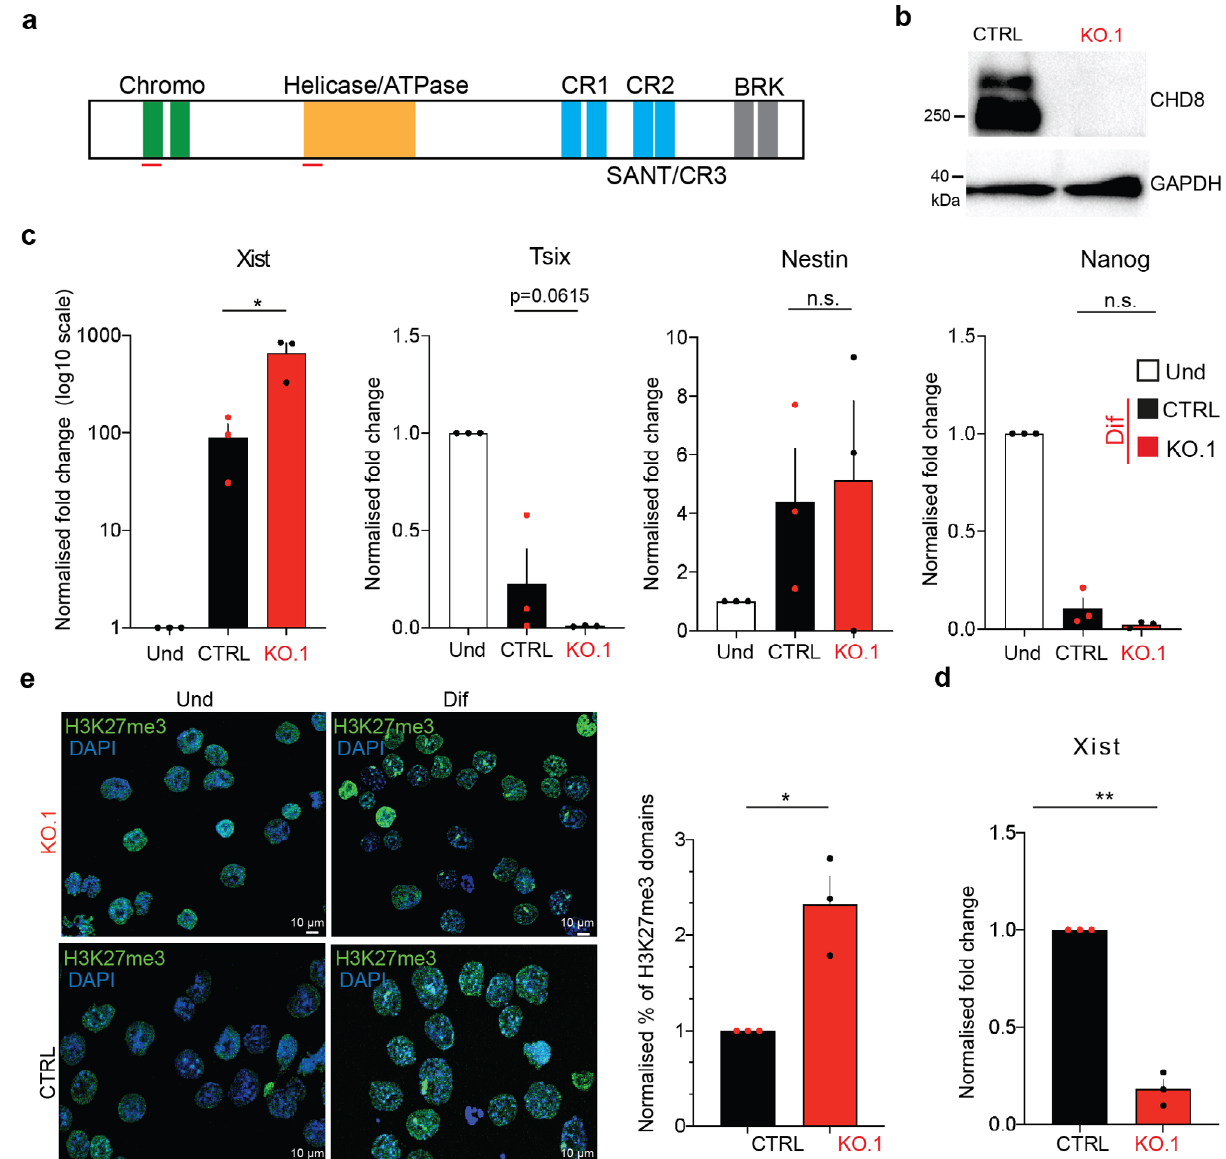
Fig. 3 Chd8 KO affects XCI initiation. a Schematic representation of Chd8 protein domains; red lines indicate the position of the CRISPR/Cas9 guides used (not in scale). b Western Blot analysis of Chd8 KO.1 (clone C4.1) and parental ES cells (CTRL, Fa2L-S4) are shown. c qRT-PCR results showing expression levels of Xist, Tsix , Nestin , Sox2 . In differentiating ESCs Xist is strongly up-regulated in Chd8 KO cells whilst cell differentiation is not affected ( Nestin , Nanog); CTRL, parental cell line: Fa2L-S4; KO, sub-clone C4.1. Data is normalised for the undifferentiated condition (Und). Data from three independent experiments is shown. p -values, Xist = 0.0367. d Xist qRT-PCR data from parental (CTRL) and KO.1 cells in undifferentiated state is shown. Und (undifferentiated cells), Dif (3 day differentiated cells). Data from three independent experiments is shown. Error bars represent standard error of the mean (SEM). Statistical signi fi cance was tested by means of two-tailed unpaired t -test (* p ≤ 0.05; ** p ≤ 0.01). p -values, Xist = 0.00362. Single points represent independent biological sample. Gapdh was used as internal normalization control. e Representative images of H3K27me3 in CTRL vs. Chd8 KO cells (left) and the normalised scoring of H3K27me3 domains (IF) is shown (right), n = 658. Data from three independent experiments is shown. Error bars represent standard error of the mean (SEM). Statistical signi fi cance was tested by means of two-tailed unpaired t -test (* p ≤ 0.05; ** p ≤ 0.01). CTRL vs. KO.1, p -value = 0.0463. Single points represent independent biological